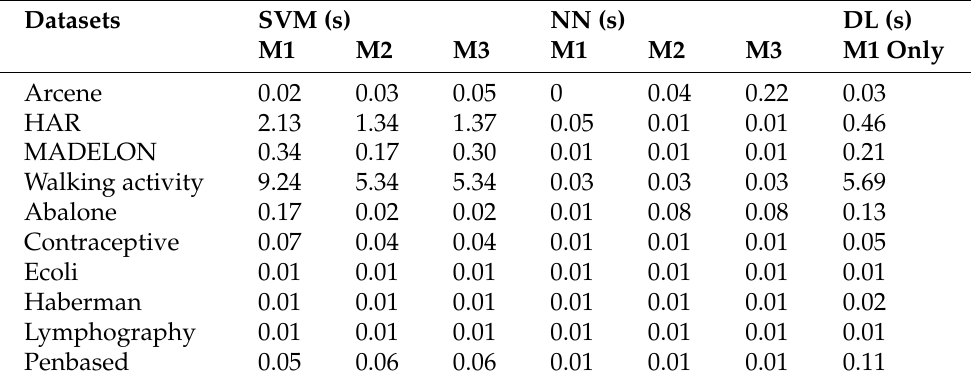
Table 6. Computational time taken of SVM, NN and DL on testing datasets.